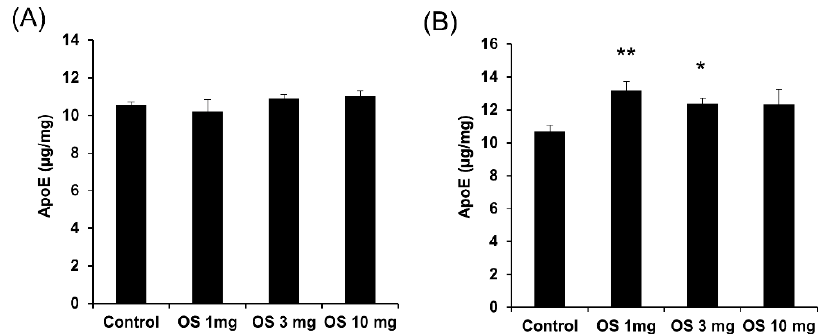
Figure 6. Effects of OS in vivo. apoE levels in the brain ( A ) and the liver ( B) of apoE3-TR mice (male, four months old) were determined by ELISA after one week of daily intraperitoneal (i.p.) administration of OS (1 mg/kg/day, 3 mg/kg/day, or 10 mg/kg/day). Data represent mean ± SE ( n = 4, biological replicate group). * p < 0.05, ** p < 0.01; Tukey-Kramer